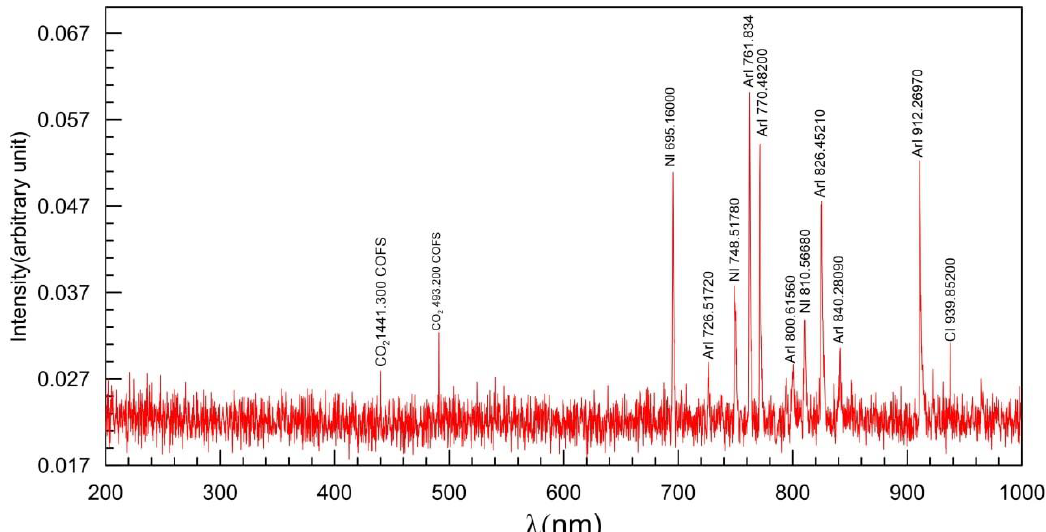
Figure 7: The emission spectrum of DBD plasma in the presence of cyclohexane